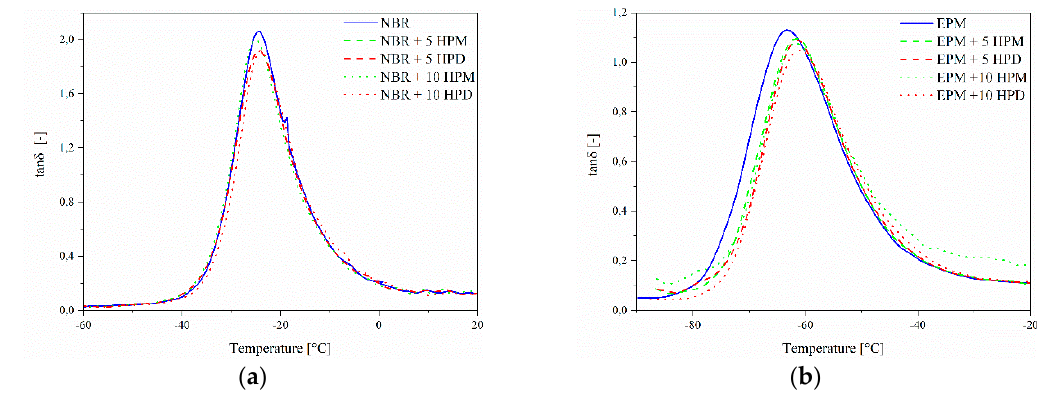
( b ) Figure 12. Loss modulus of ( a ) NBR and ( b ) EPM composites filled with hybrid pigments as a function of temperature. Figure 13 presents the tan δ versus temperature curves for the investigated composites. The tan δ peak is related to the polymer glass transition temperature ( T g ). In the glass transition region, the energy dissipation originates mainly from the segmental motion of the macromolecular chain of the rubber matrix [42]. Interestingly, the height of the tan δ peak was gradually reduced with increasing pigment loading in both the NBR and EPM matrixes, most probably due to the restricted mobility of the rubber chains. However, for EPM composites, the glass transition temperature values were noticed to shift about 2.0 °C toward higher temperatures with the addition of hybrid pigments, while for NBR no visible changes were observed. Since the T g shift was not dependent on the pigment type and concentration, we suggest that the main reason for this effect may have been the nature of the curing system. It was already reported [43] that a sulfur-based curing system shows a tendency for